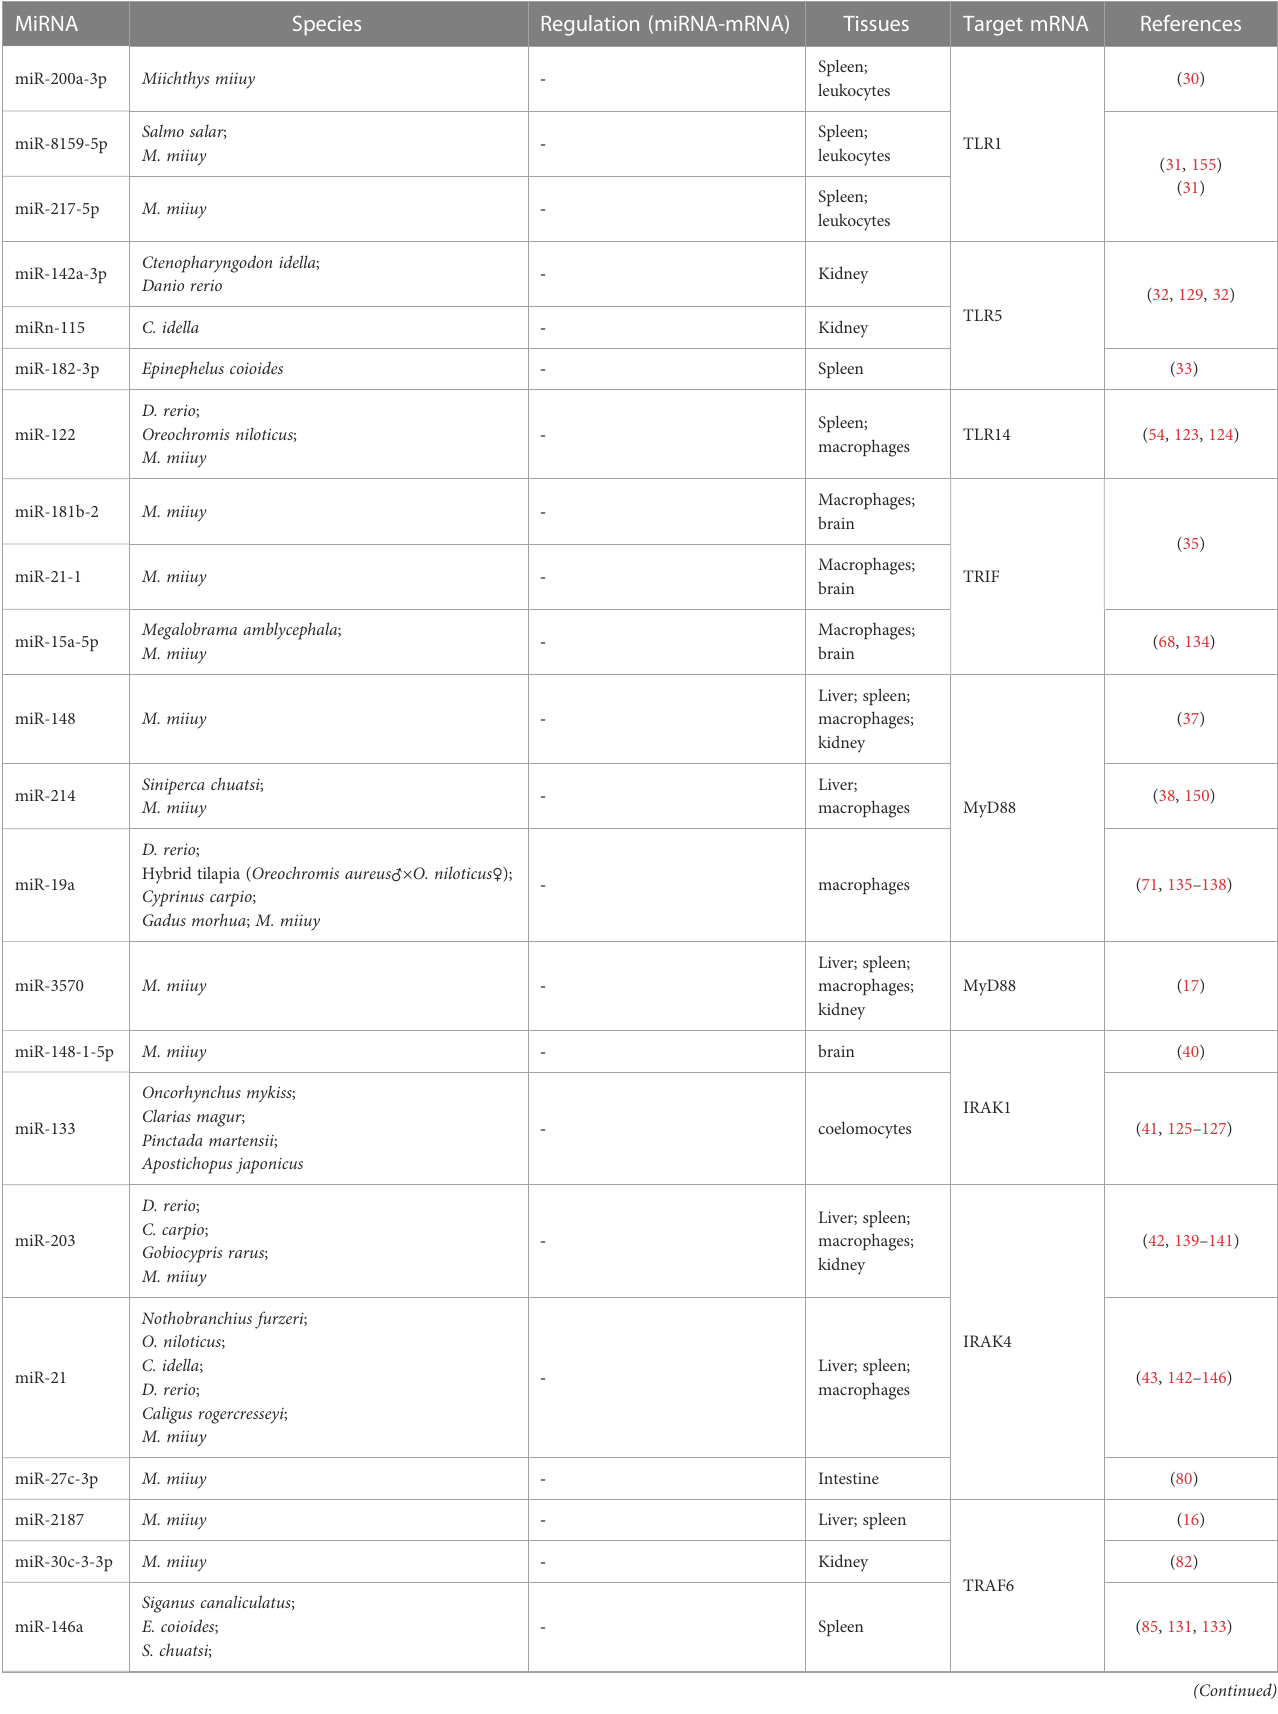
TABLE 3 Summary of identi fi ed microRNAs (miRNAs) targeting genes of nuclear factor-kappa B (NF- k B) pathways in aquatic animals. “ - ” : negative regulation between miRNA and mRNA after experimental validation.